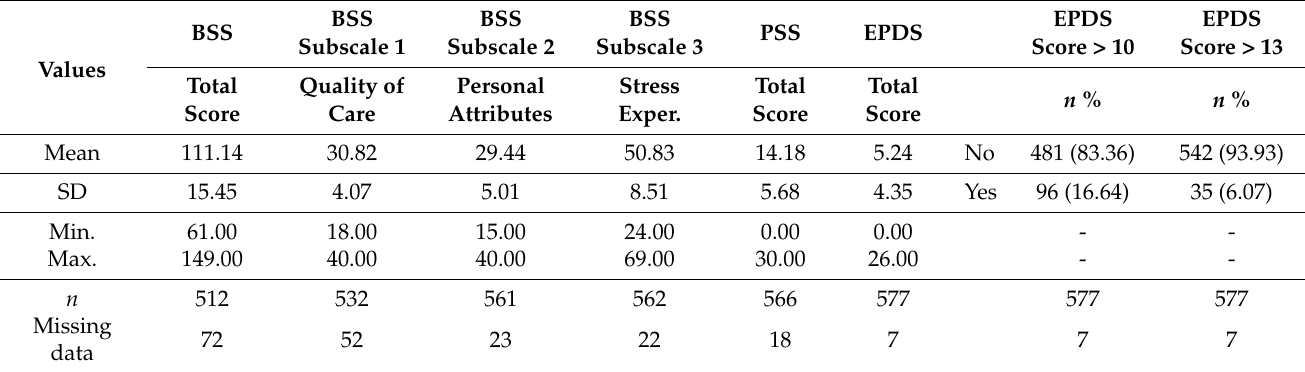
Table 3. Basic characteristics of BSS, EPDS and